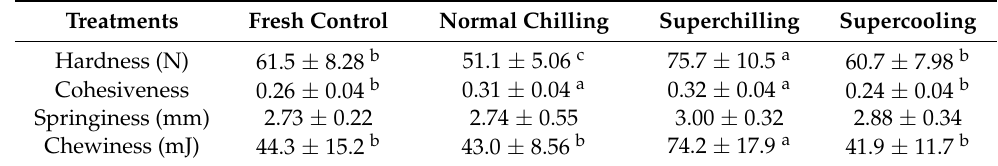
Table 3. Comparisons of texture profile analysis (TPA) parameters of beef loins after 15 days of preservation.